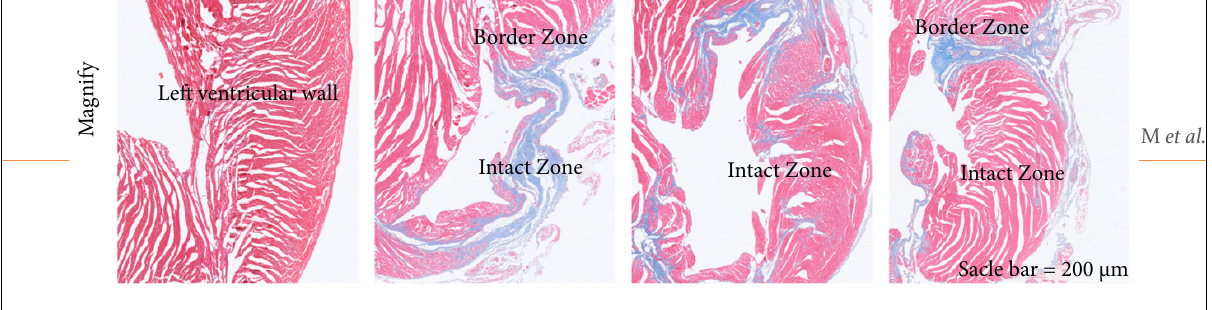
structure, and significantly weaken fibrosis and infiltration of inflammatory cells.